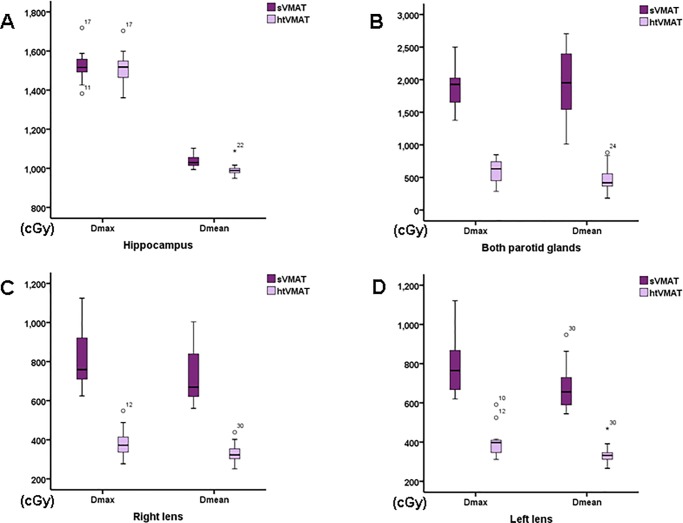
Box plots of Dmax and Dmean to (A) the hippocampus, (B) both parotid glands, (C) right lens and (D) left lens.